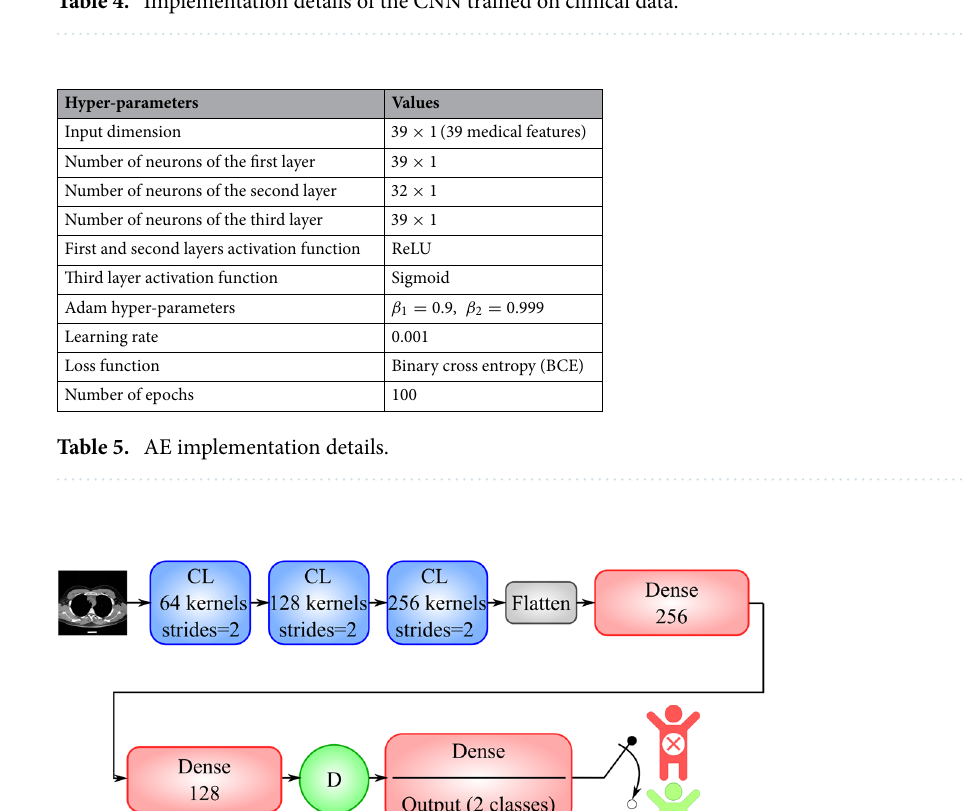
Table 4. Implementation details of the CNN trained on clinical data.